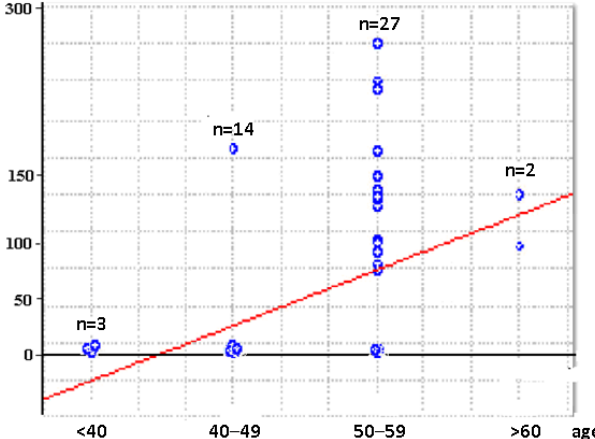
Figure 4. Dependence of the aberrantly methylated RAR β 2 gene plasma concentration and the age of HFs.